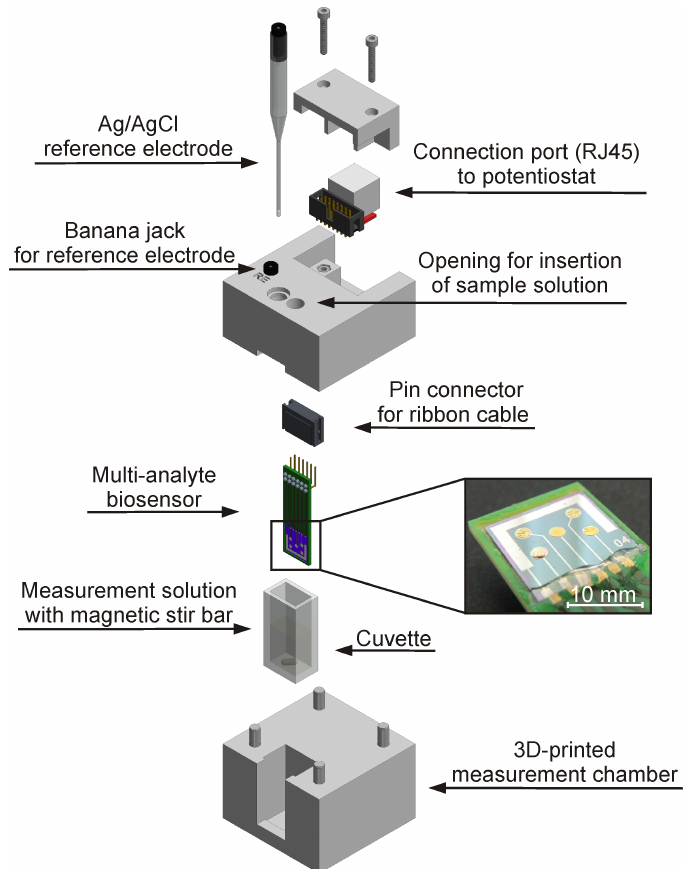
Figure 2. Explosion drawing of the compact three-dimensional (3D)-printed measurement set-up (60 × 60 × 70 mm 3 ) for facile application of the multi-analyte biosensor. Close-up shows biosensor chip (14 × 14 mm 2 ) with five working electrodes and an integrated counter electrode, incorporated into a printed circuit board, with immobilized enzyme membranes on the working